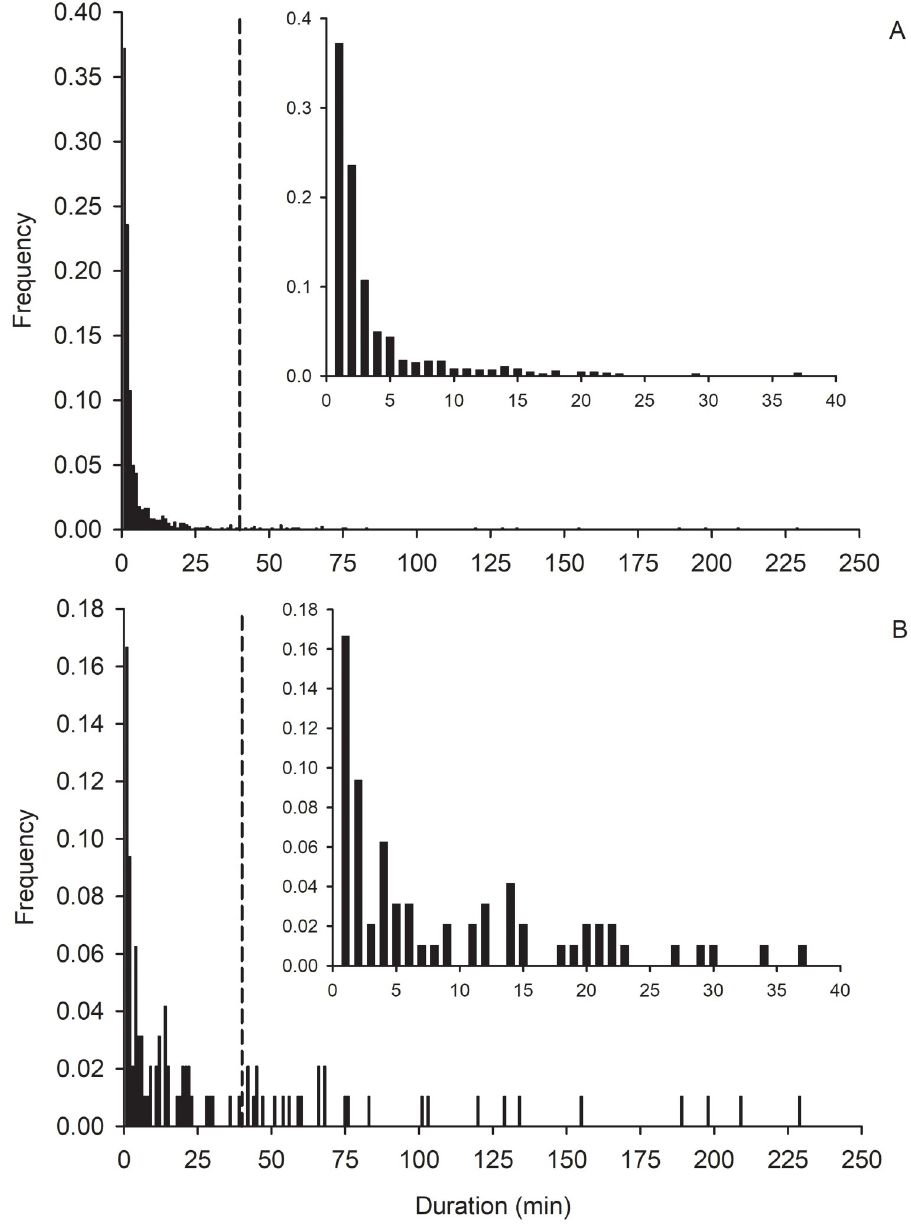
Fig 3. Frequency distribution of durations of (A) all flights, and (B) longest single flights by female western corn rootworm in the voluntary flight experiment. Dashed line marks 40 min. Inset figures represent frequency of durations from 1 min to 40 min of flight. Flights lasting < 1 min were